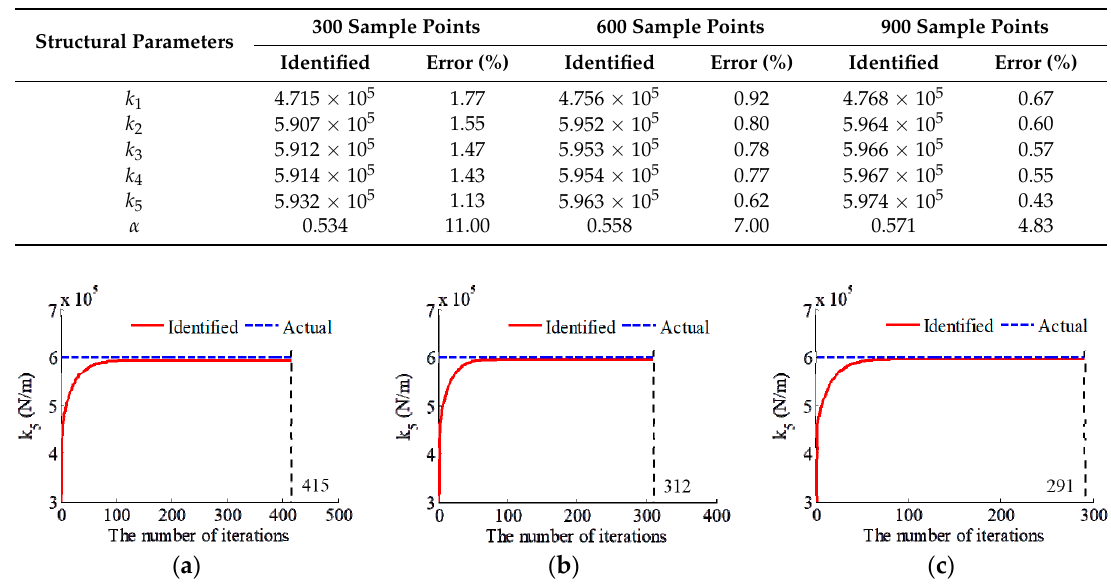
Figure 7. Comparison of the identified k 5 using different numbers of sample points: ( a ) using 300 sample points; ( b ) using 600 sample points; ( c ) using 900 sample points.